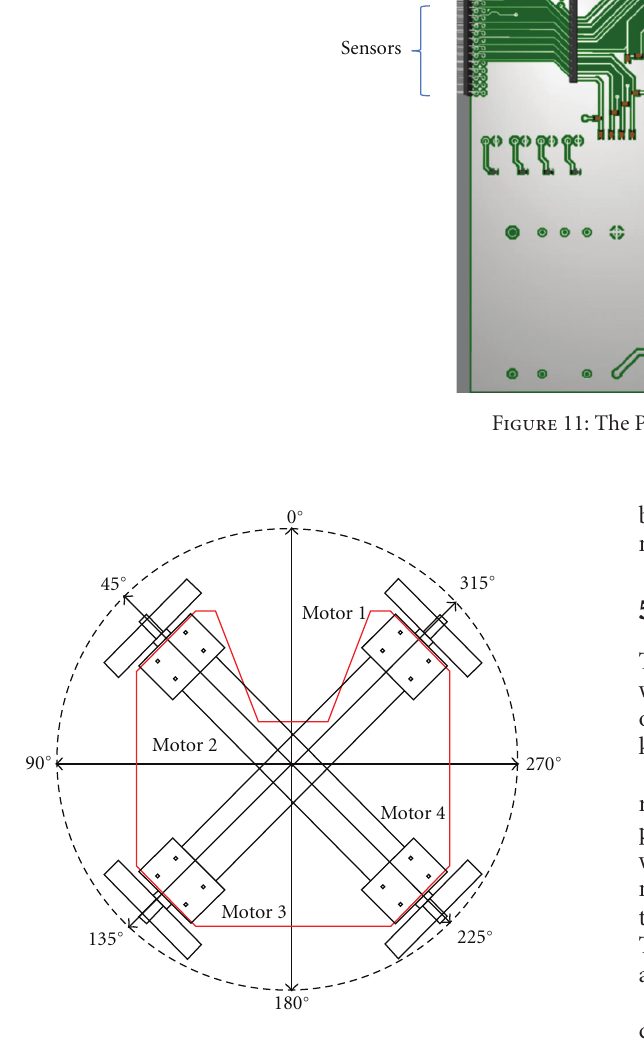
Figure 12: Eight di ff erent directions.